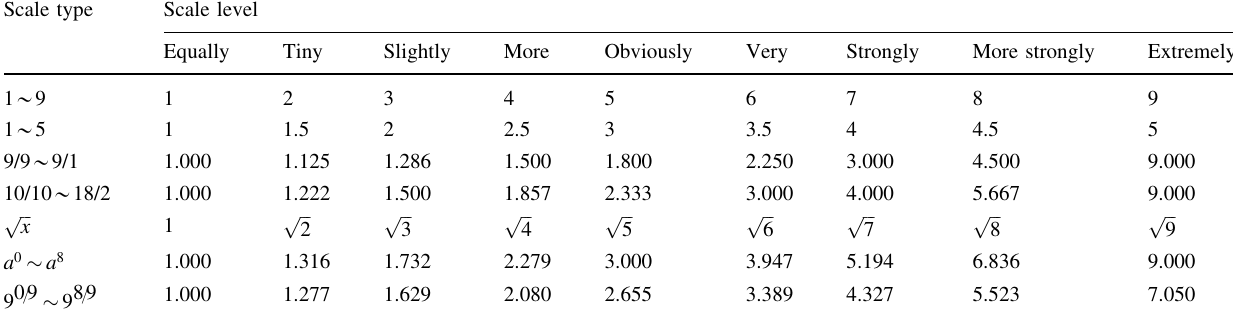
Table 6 Scale level and the scale type